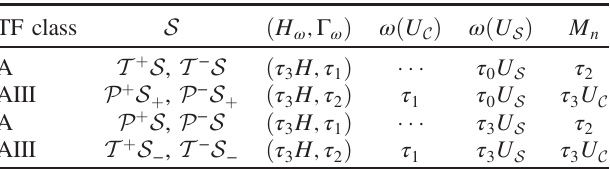
TABLE XIV. The action (36) of the order-raising homomor- phism ω on a Hamiltonian in the complex tenfold-way classes with an antiunitary order-two symmetry or antisymmetry. M the crystalline-symmetry-breaking mass term generated by the homomorphism ω .